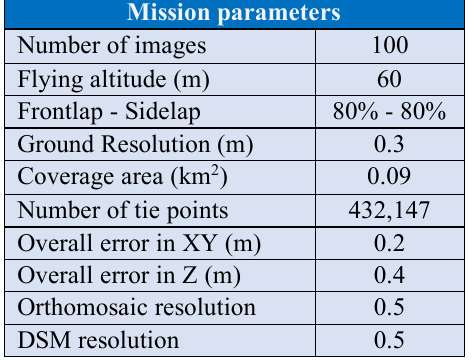
Table 1. Mission parameters for Proussos case site